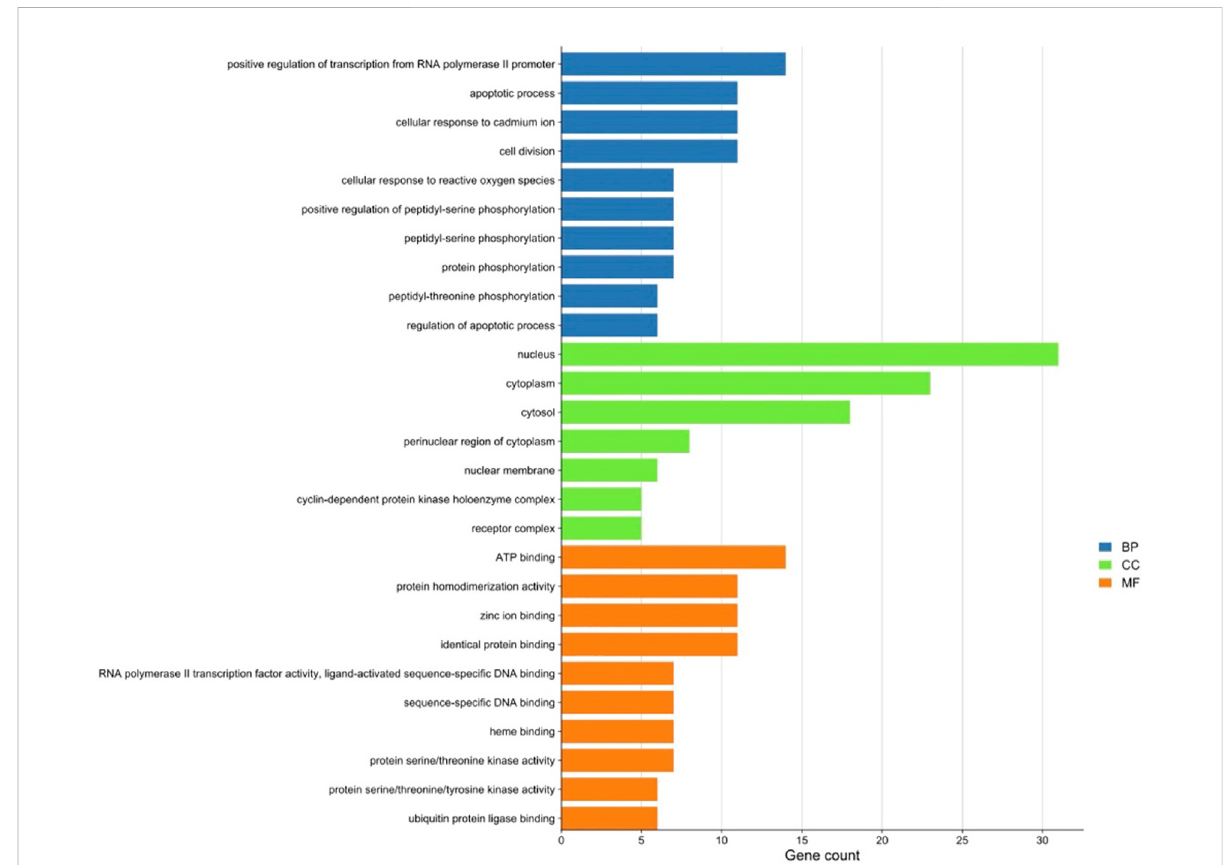
FIGURE 2 Gene ontology (GO) enrichment analysis of intersected targets. Top ten biological process (BP) terms, cellular component (CC) terms, and molecular function (MF) terms are shown as green, orange, and purple bars, respectively. The X -axis represents the gene count of the target, and Y -axis represents the GO category of the target